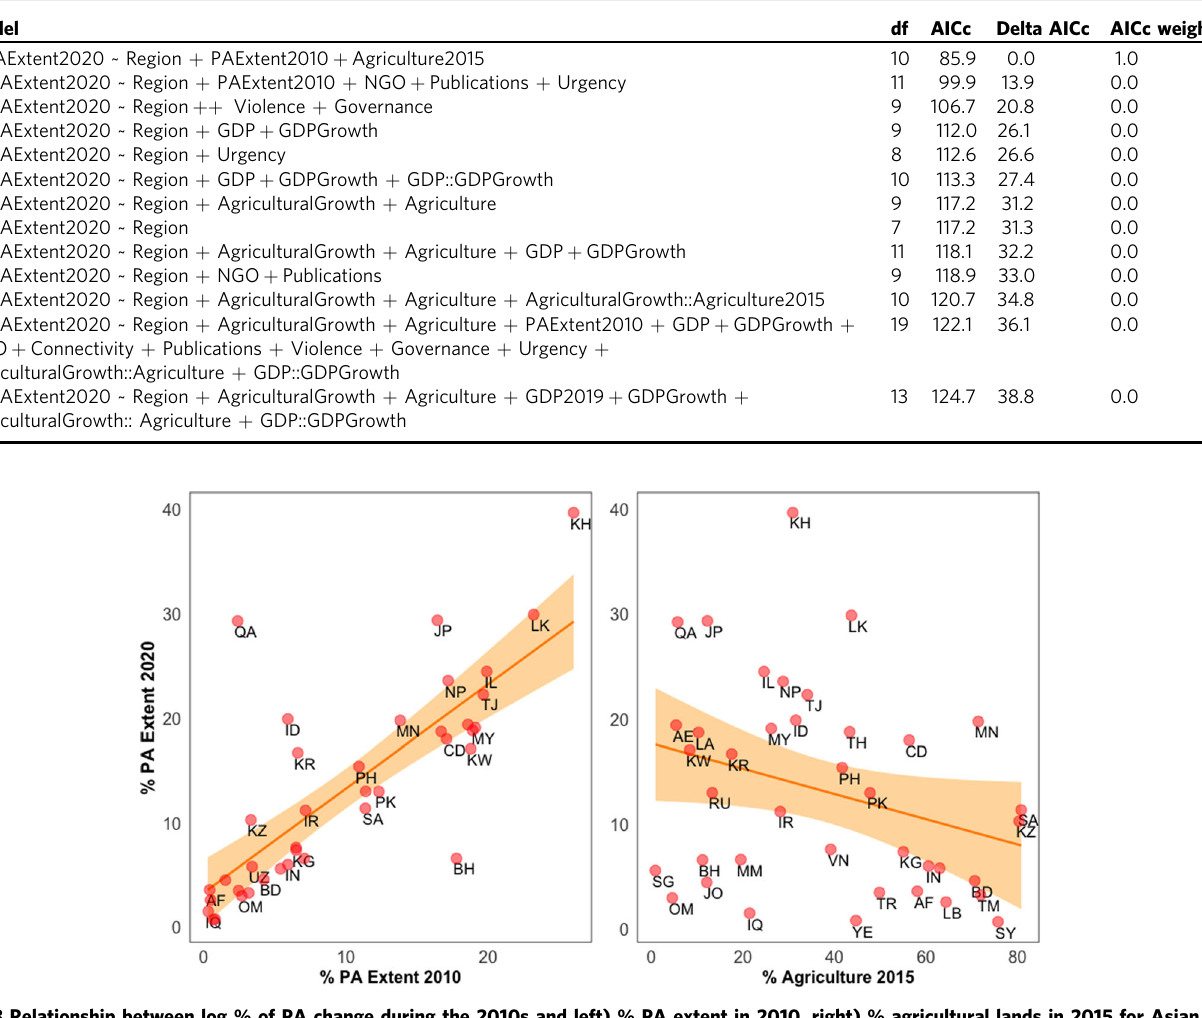
Fig. 3 Relationship between log % of PA change during the 2010s and left) % PA extent in 2010, right) % agricultural lands in 2015 for Asian continent, based on generalized linear models. See Supplementary Table 1 for two-letter country